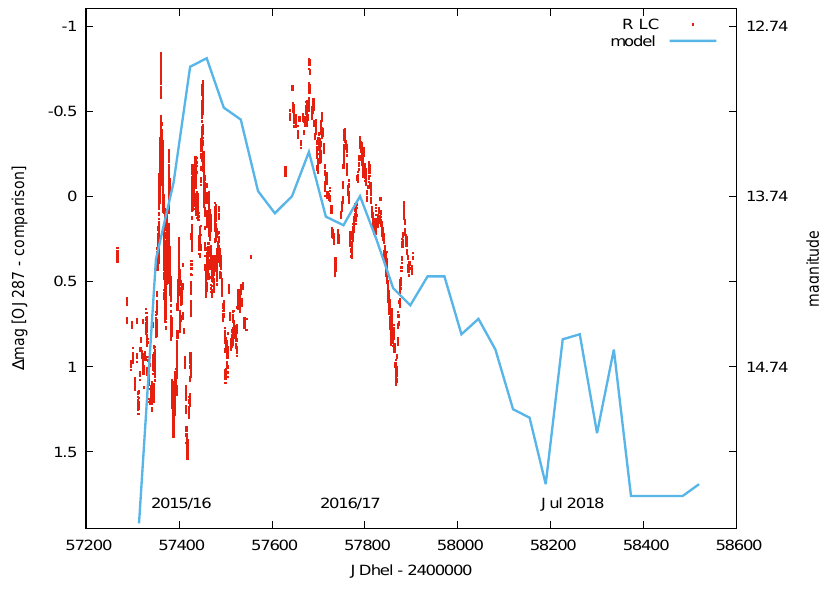
Figure 4. Prediction of OJ 287 brightness